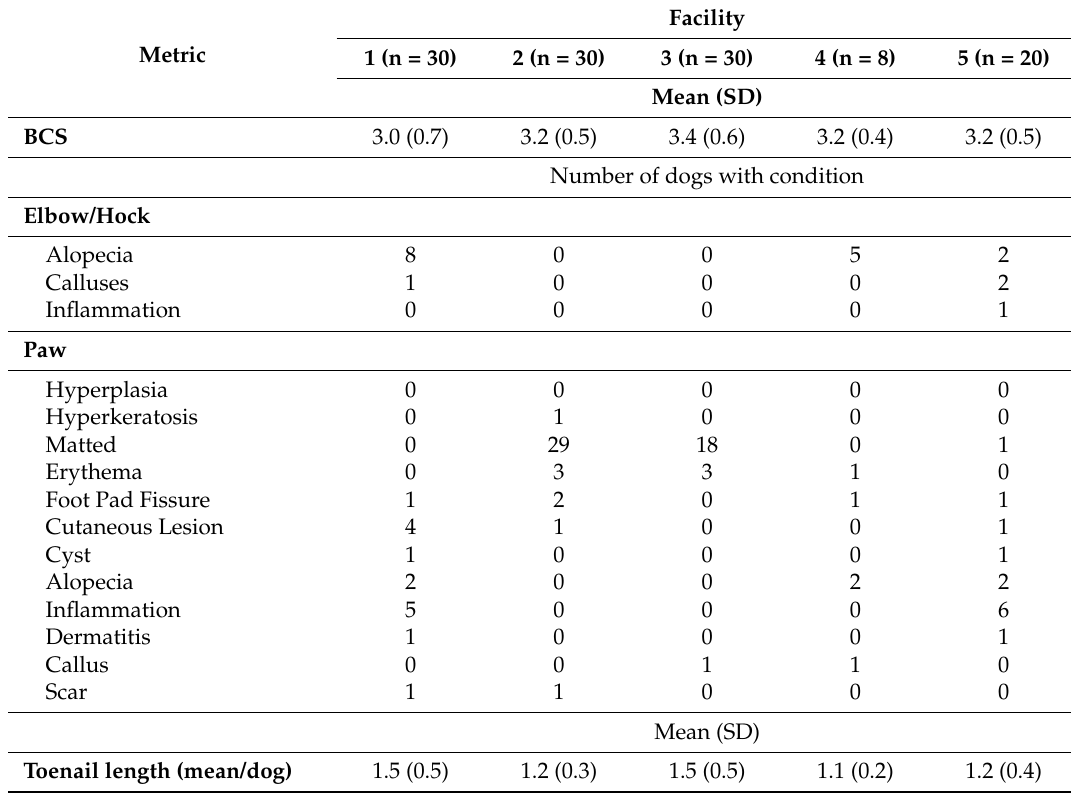
Table 4. Physical exam. Summary of the results of the physical exam. BCS: body condition